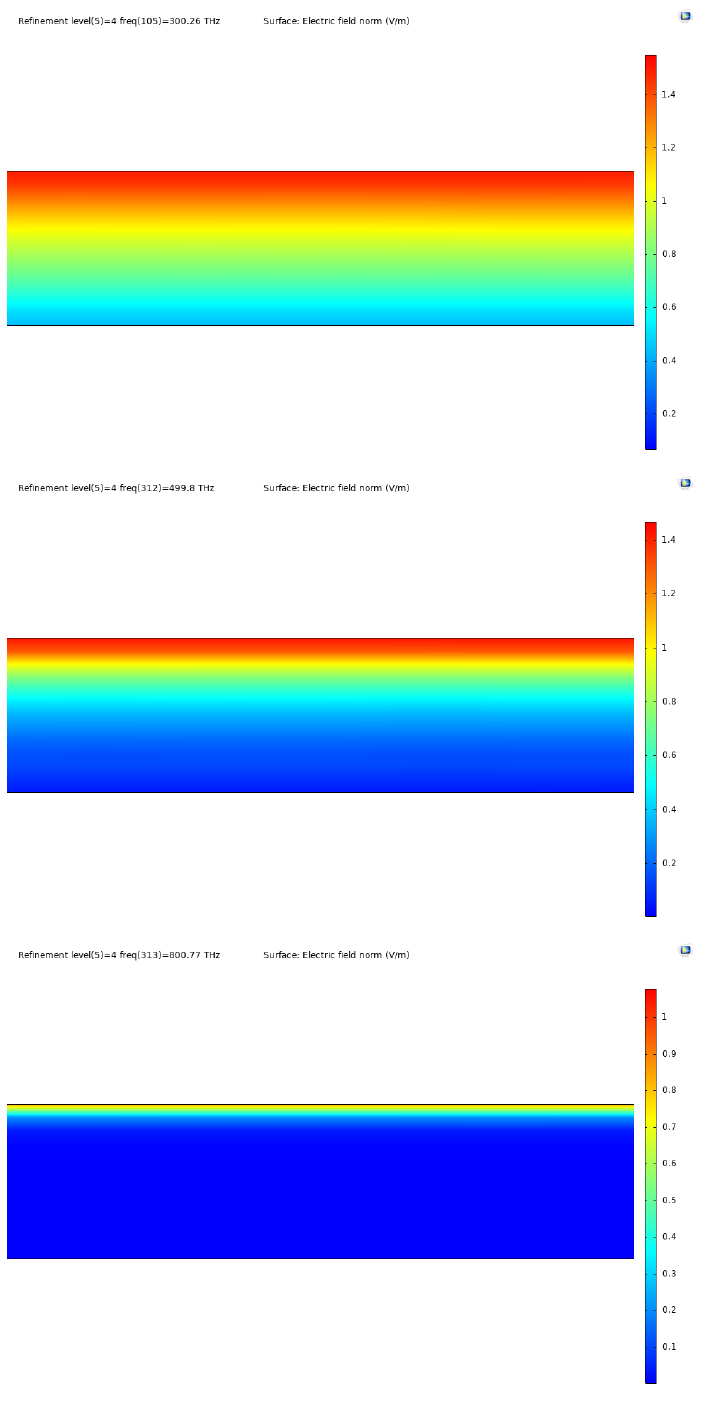
Figure 3. Electric field norm for different frequencies for Al 0.18 Ga 0.33 In 0.49 P , at 300 THz, 500 THz and 800